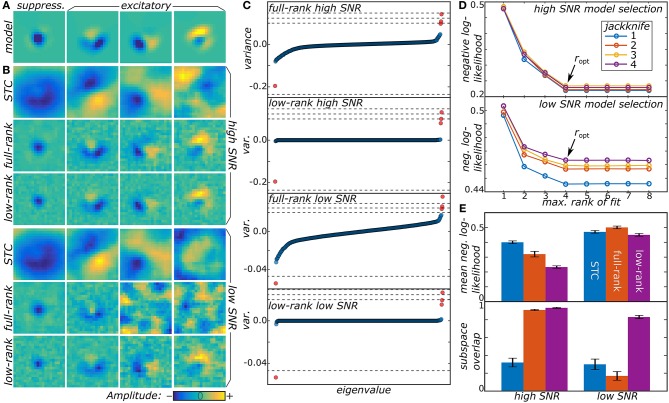
(A) Two model neurons were generated from a synthetic receptive field, one with high SNR and another with low SNR. (B) Low-rank MNE, full-rank MNE, and STC models were optimized for both of the neurons and the mean top four largest magnitude components of J were plotted. (C) These mean components correspond to the largest variance eigenvalues in the eigenvalue spectra. The dashed lines in the eigenvalue spectra correspond to the eigenvalues of the ground truth, JGT. (D) Low-rank models with maximum rank ranging over r = 1…8 were trained on four different jackknives of the data set where for each jackknife the data set was split into a training and cross-validation set. The predictive power of each jackknife's trained models evaluated on its cross-validation set is shown to saturate when r ≥ ropt = 4. (E) Quantitative comparisons of the receptive field reconstructions from the three methods is compared based on each model's predictive power on the test sets (top) and the subspace overlap onto the ground truth (bottom).